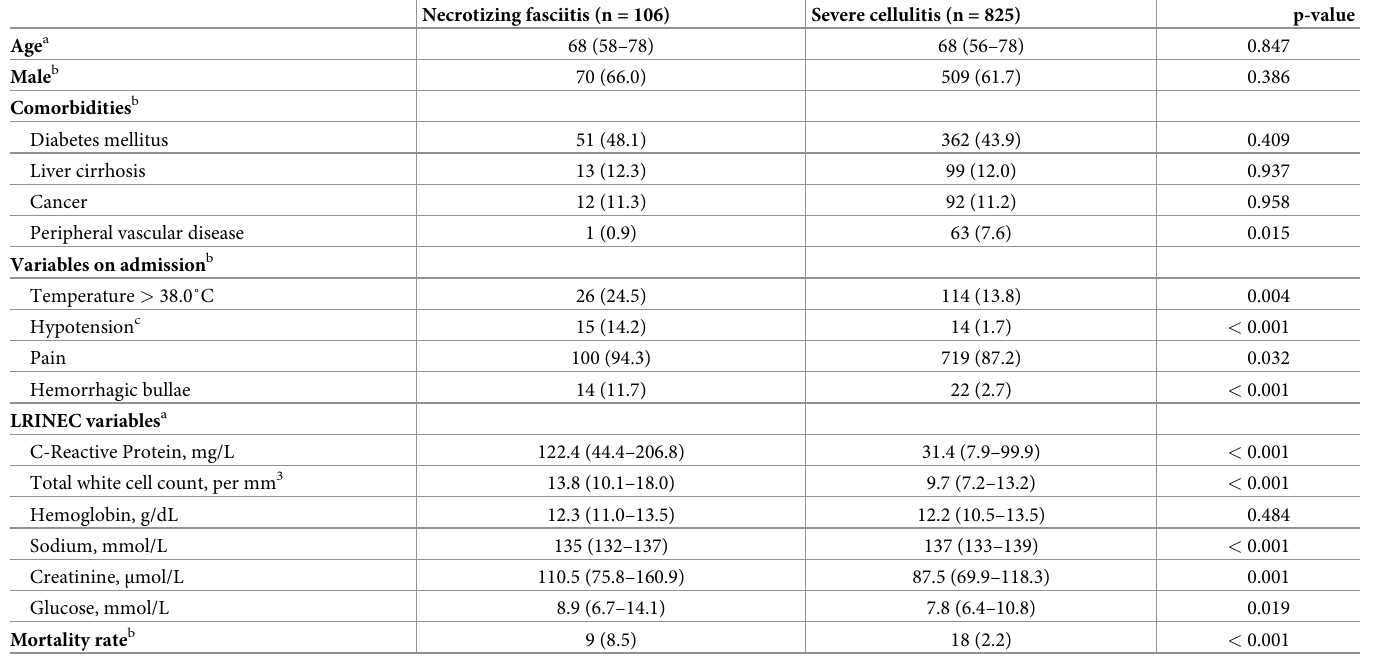
Table 1. Demographic and clinical variables of patients used in the validation cohort.